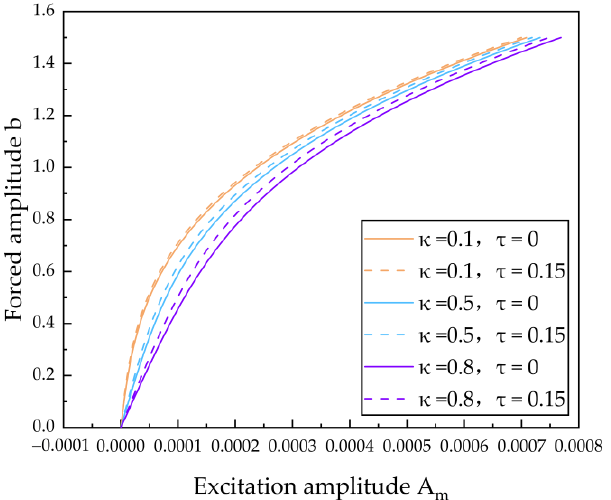
Figure 6. Forced amplitude versus excitation amplitude with a different viscoelastic damping